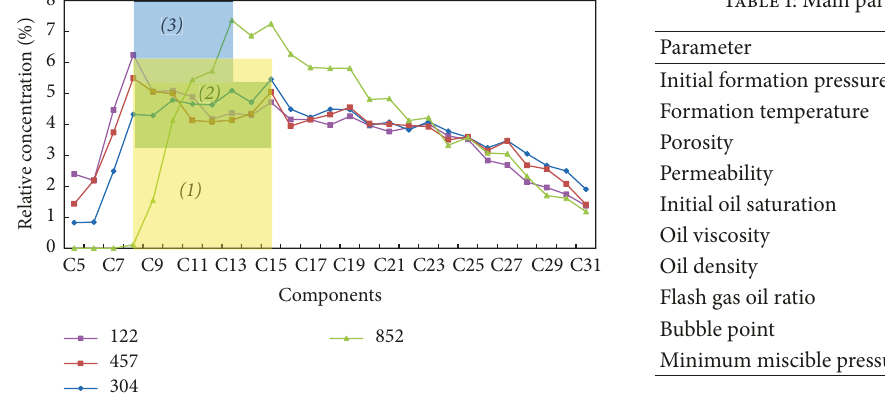
Figure 1: Relative concentration of produced oil compositions of production well W1 at different injection time.